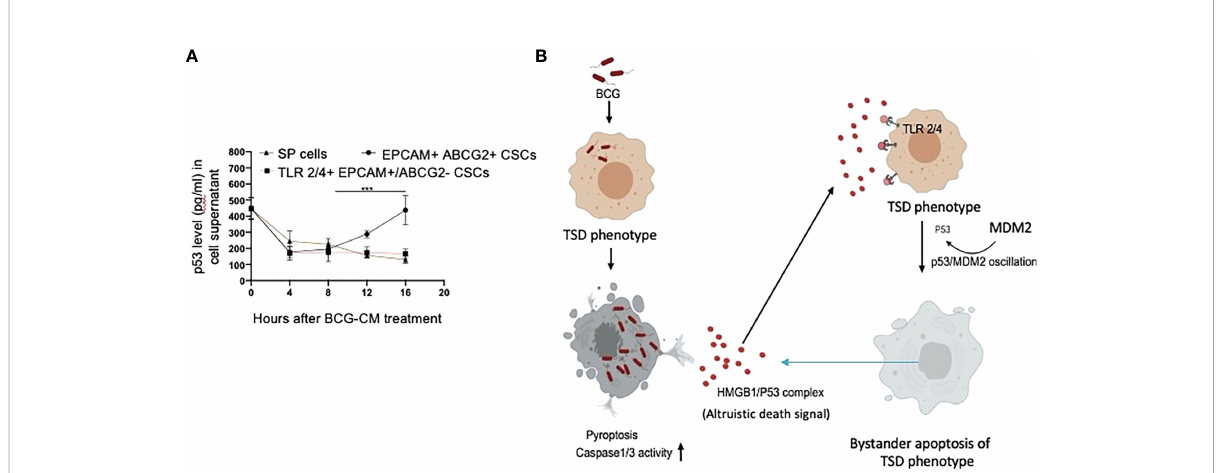
FIGURE 9 Tumor stemness defense (TSD) phenotype can amplify the pathogen-induced bystander apoptosis (PIBA). (A) The p53 uptake assay in the culture supernatant was measured from 0 to 16 h of BCG-CM treatment in the cells. The SCC-25 SP cells were obtained as described in Figure 1 Data represent mean +/- SEM, n= 3 independent experiments. ***p < 0.0001, student t test. (B) Potential mechanism of TSD phenotype – mediated niche defense of CSCs against BCG infection. In the infected CSCs, as part of the Altruistic stemness – based (37) niche defense mechanism (6, 16, 17) HMGB1 form a complex with cytoplasmic p53 to make an, “ altruistic death signal ” . TLR4 internalizes the altruistic death signal, leading to induction of p53/MDM2 oscillation and activation of p53-induced pro-apoptotic genes. The EpCAM+/ABCG2+ CSCs undergoing bystander apoptosis further release the HMGB1/p53 death complex into the TME, amplifying